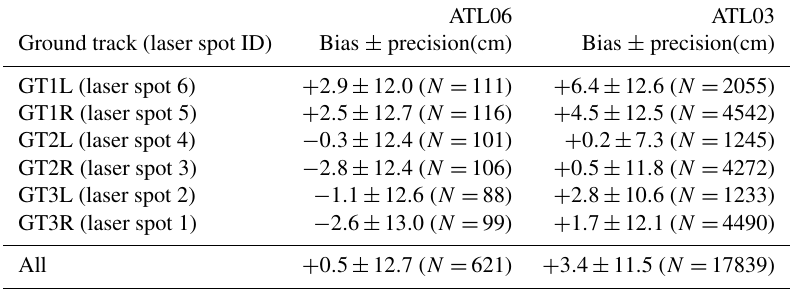
Table B1. Assessment of ICESat-2 ATL06 ice surface points and ATL03 photons using the GNSS PPK technique at all intersections along the GNSS traverse. Bias and precision were estimated from their elevation differences using N ice surface points or photons. The difference is calculated as ICESat-2 elevation minus GNSS elevation.